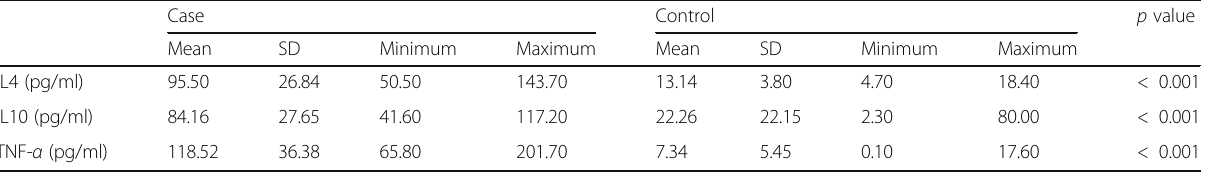
Table 1 Comparison of patient and control groups regarding levels of cytokines Case Control